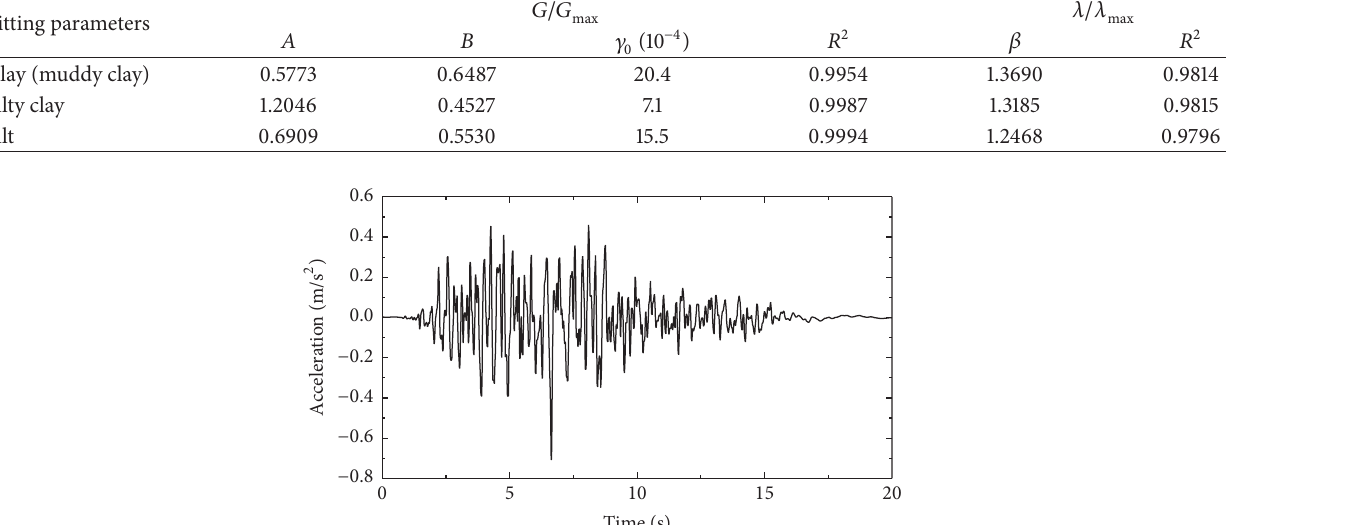
Figure 2: The synthetic horizontal seismic acceleration time-history wave of 70 m below ground surface within the exceeding probability 10% in 50